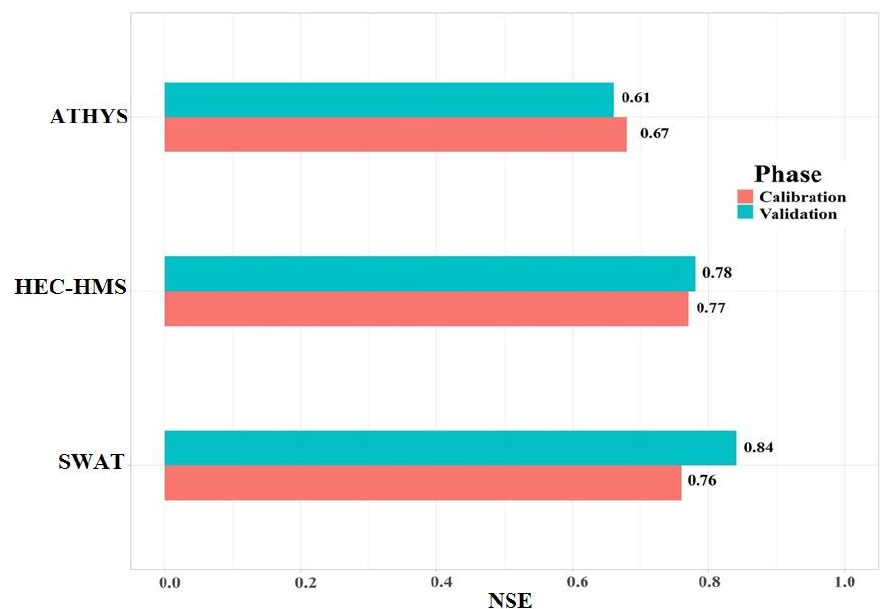
Figure 4. The Nash – Sutcliffe coefficient for different hydrological models estimated for the calibra- tion and validation period. and validation